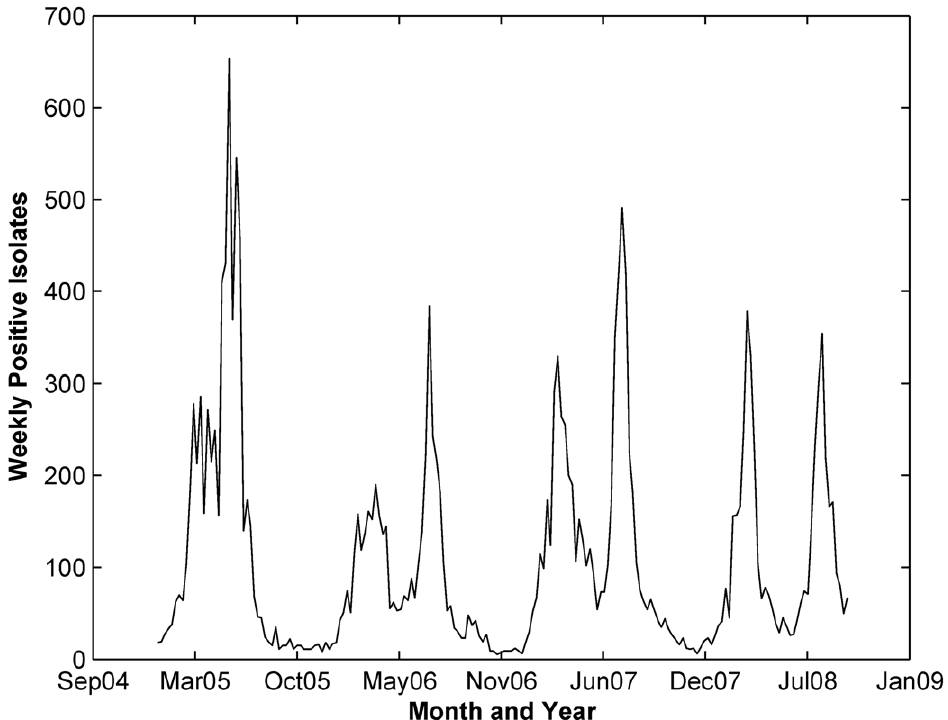
Figure 1. Hong Kong weekly influenza positive isolates.